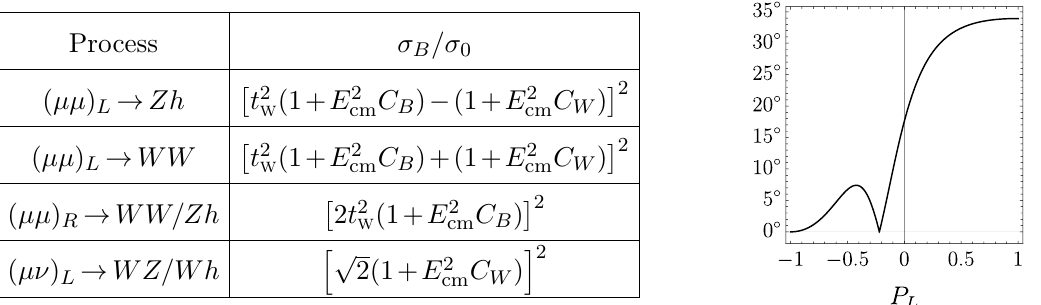
Figure 8. Left: Born-level cross-sections, with t w the tangent of the Weinberg angle, normalized to a common σ (whose expression is irrelevant). Right: the angle between the ZH and WW 0 cross-section gradients as a function of the beam polarization